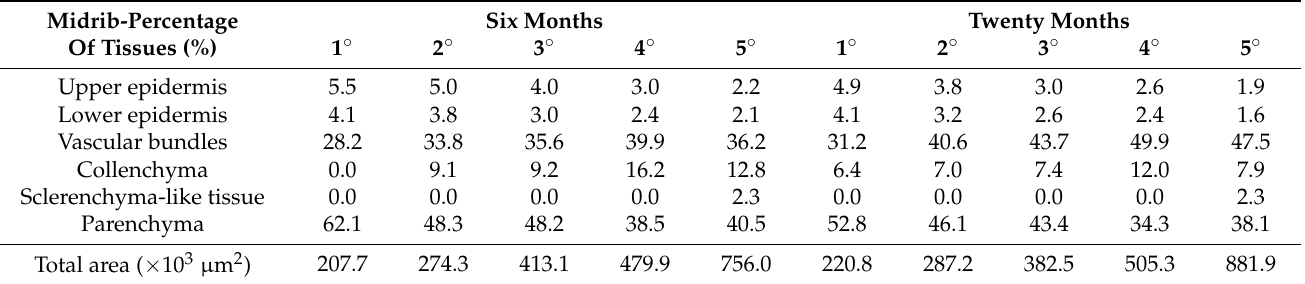
Table 2. Percentage of tissues in the upper and lower epidermis, vascular bundles, collenchyma, sclerenchyma-like tissue, parenchyma and total area of the midrib for the five growth stages of Eucalyptus grandis leaf development stages of 6- and 20-month-old plants.